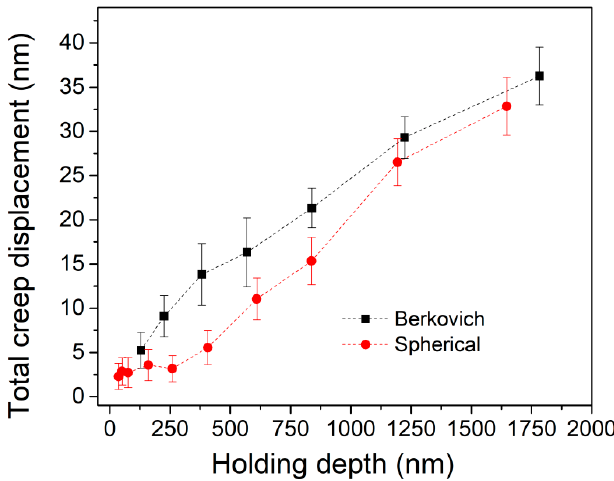
Figure 2. The total creep displacements in the end of holding stage were plotted with holding depth for both indenters.